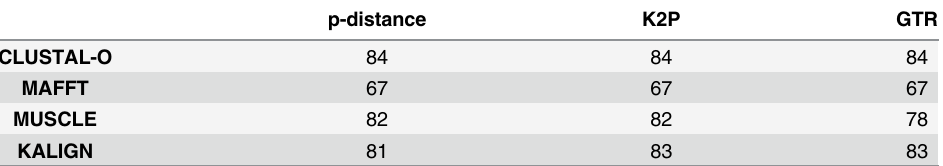
Table 2. Number of OTUs identified. The number of OTUs is reported given the alignment algorithm, the genetic distance calculation methodology and the a priori established primary intraspecific distance partitions in ABGD. p-distance, the proportion (p) of nucleotide sites at which two sequences being compared are differ- ent; K2P distance, Kimura ’ s 2-parameter distance correction which takes into account transitional and trans- versional substitutions while assuming equal nucleotide frequencies and invariable substitutional rates among sites; GTR, General Time Reversible evolutionary model based on six substitution rate parameters and 4 equilibrium base frequency